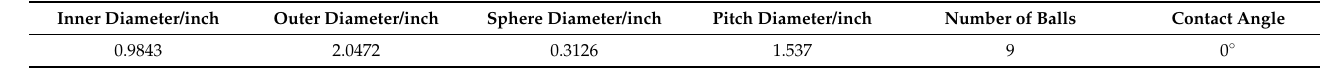
Table 3. 6205-2RS JEM SKF Bearing Parameters.